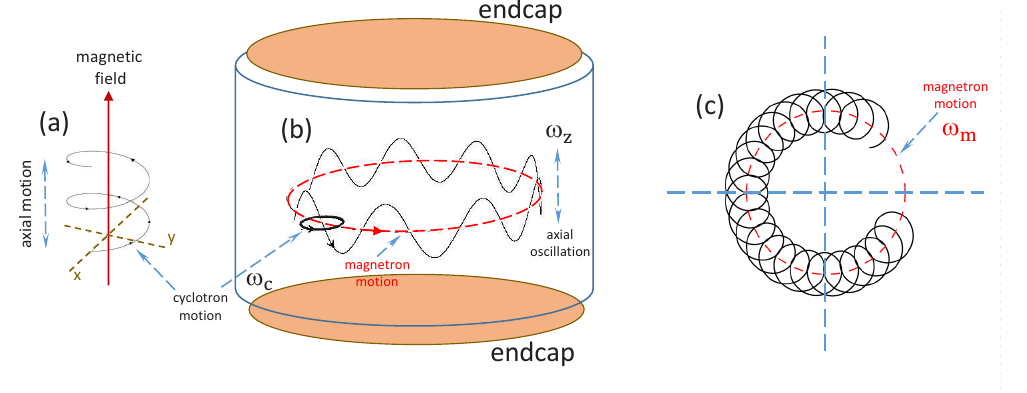
Figure 1. Motions of an ion in a Penning trap. ( a ) Cyclotron motion around a magnetic field line; ( b ) illustration of the axial oscillation and magnetron motion around the center of the trap; ( c ) circular motions of an ion confined in a Penning trap, projected onto the trap